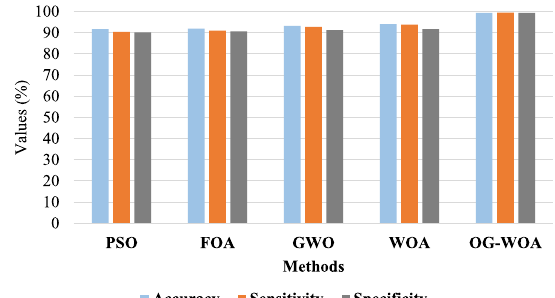
Fig. 10 Comparison of feature selection methods on UCM dataset